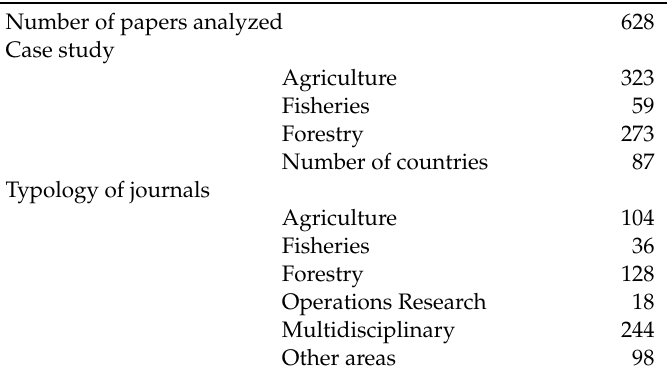
Table 1. Basic results of the survey.